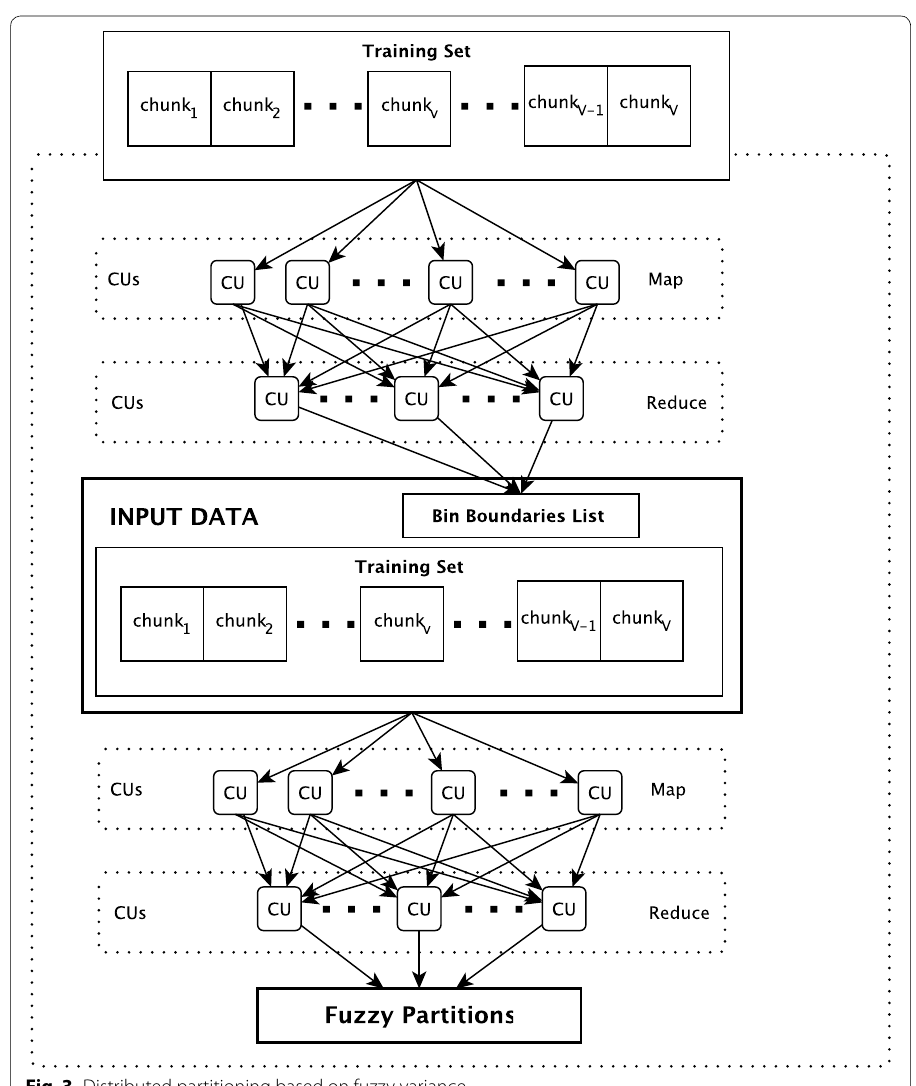
Fig. 3 Distributed partitioning based on fuzzy